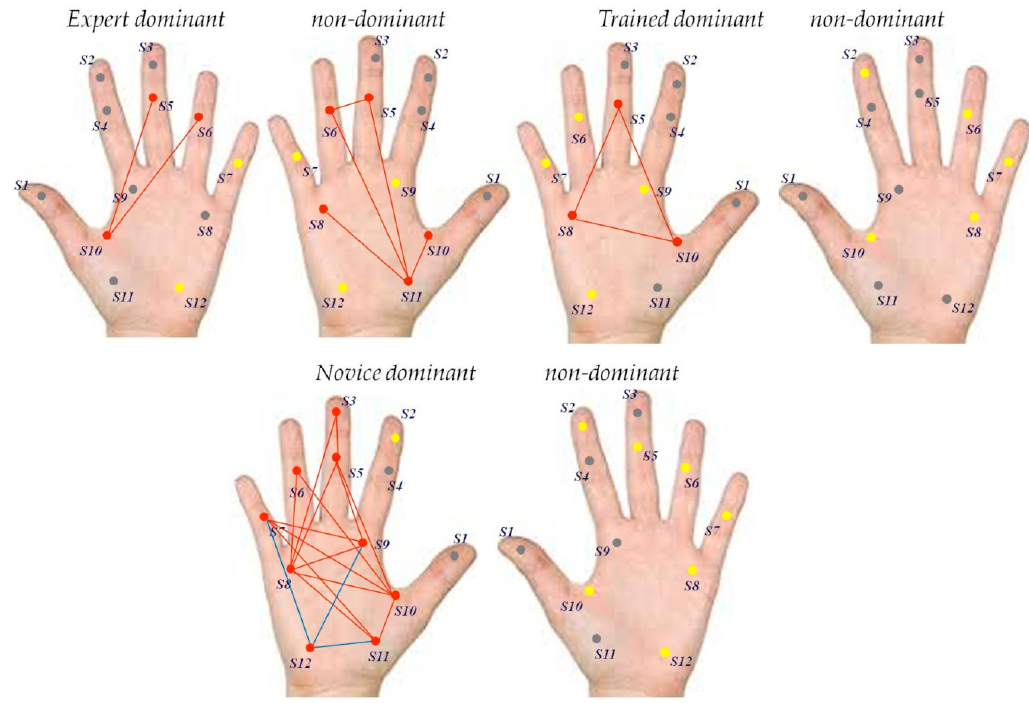
Figure 8. Functional strategy chart based on grip force signals and their positive / negative correlation, functional independence, or non-use in the precision grip task for the dominant and non-dominant hands of the expert ( top left ), the trained user ( top right ), and the expert ( bottom ). Non-activated grip force locations are highlighted as gray dots, independently active grip force locations as yellow, and significantly correlated locations as red dots. Red links between sensors indicate positive correlation, blue links indicate negative correlation.